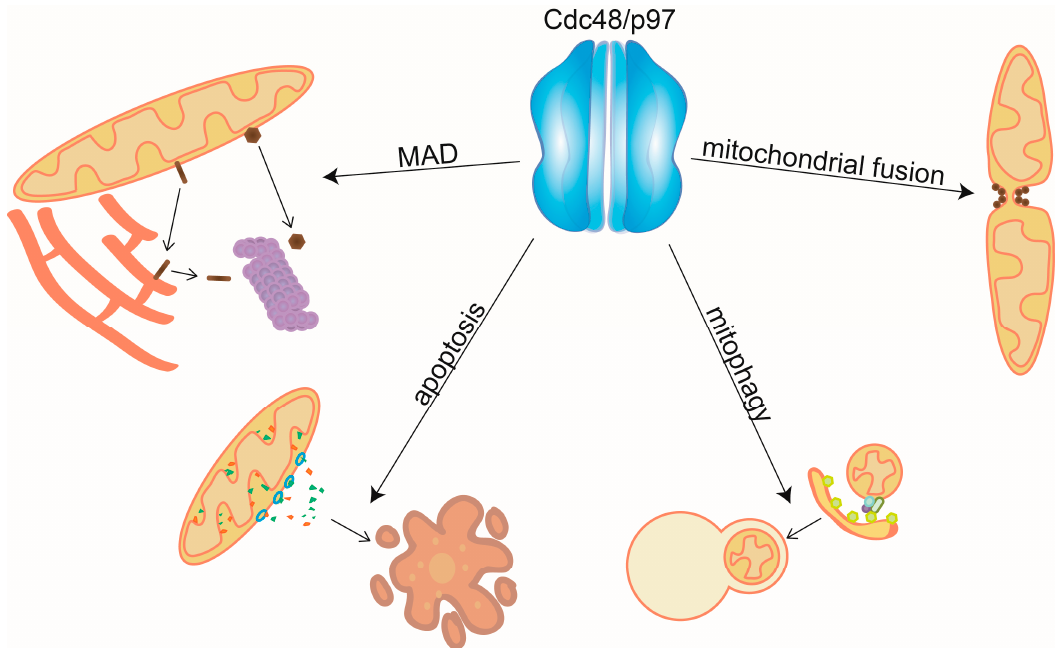
Figure 1. Mitochondrial functions of Cdc48 / p97. Cdc48 / p97 mediates mitochondrial-associated degradation (MAD), by extraction and unfolding of mitochondrial substrates and promotes mitochondrial fusion by segregating and disassembling the fusion complex. By assisting the degradation of both pro- and antiapoptotic factors, Cdc48 / p97 regulates apoptosis and by controlling the ubiquitylation levels at mitochondria it enables PINK1 / Parkin dependent